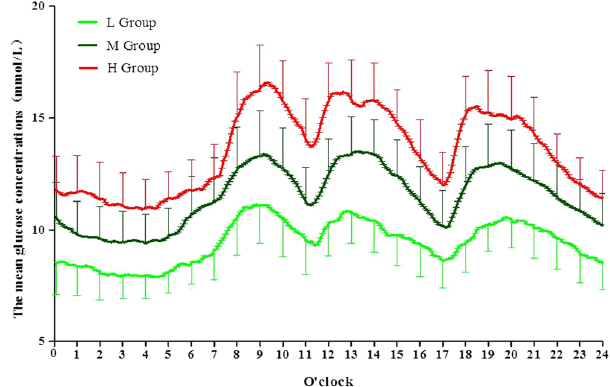
Figure 1. The average glucose concentrations per hour in the L, M, and H